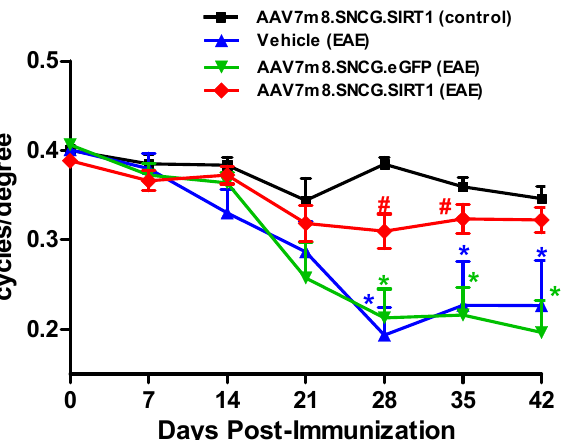
Figure 2. Effects of AAV7m8-mediated selective expression of SIRT1 in RGCs on visual function. Visual function was determined by OKR tracking using the Optometry apparatus and software. Mea- surements were performed prior to MOG immunization and once every 7 days for up to 42 days pos- timmunization in AAV7m8.SNCG.eGFP and AAV7m8.SNCG.SIRT1-treated and non-treated control and EAE mice. Data are presented as means ± SEM. * p < 0.05, AAV7m8. SNCG.SIRT1 (control) ver- sus either vehicle (EAE) or AAV7m8.SNCG.eGFP (EAE), and # p < 0.05, AAV7m8. SNCG.SIRT1 (EAE) versus AAV7m8. SNCG.eGFP. Statistical significance was determined at each time point by one-way ANOVA with Tukey’s multiple comparisons test (EAE) ( n = 13 for AAV7m8.SNCG.SIRT1 (control); n = 7 for vehicle (EAE); n = 8 for AAV7m8.SNCG.eGFP (EAE); n = 17 for